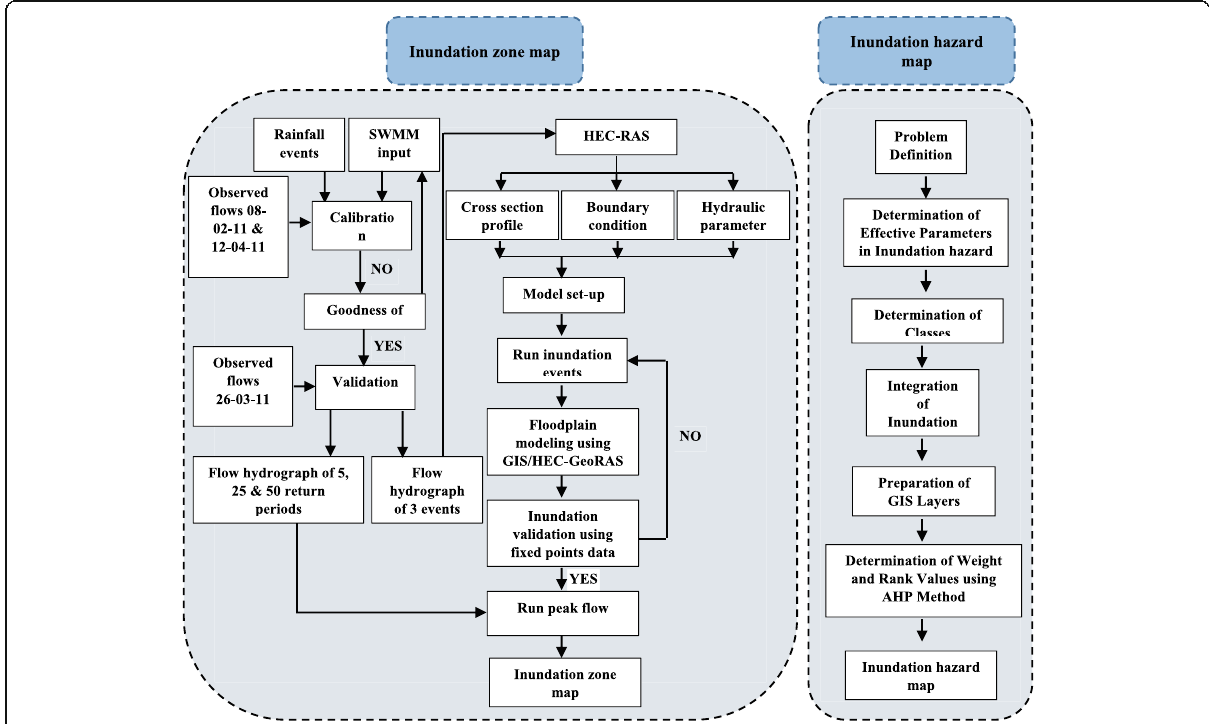
Fig. 2 Methodology flowchart of inundation zone and hazard mapping